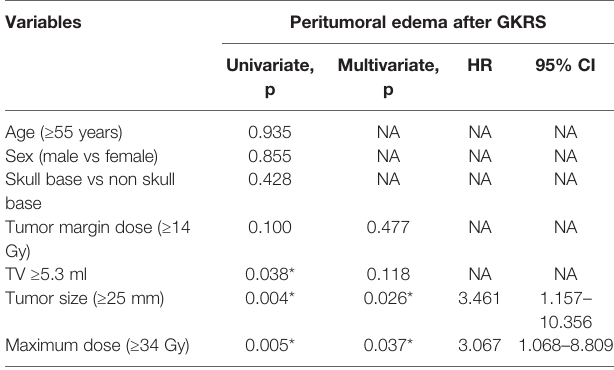
TABLE 3 | Results of univariate and multivariate analysis for peritumoral edema after GKRS.